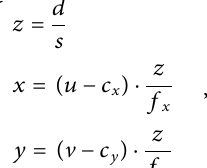
window with red dots indicating dynamic points and green